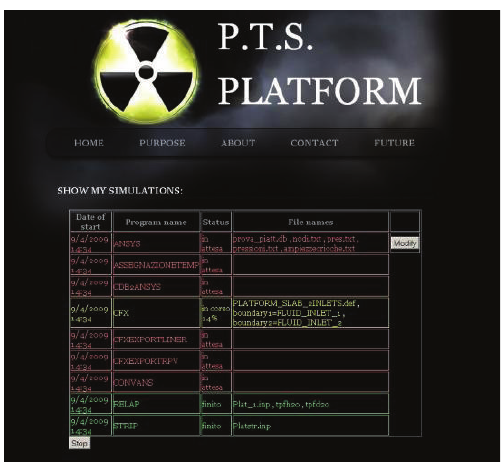
Figure 2: Physical distribution model. Figure 3: Simulation status screen-shot.